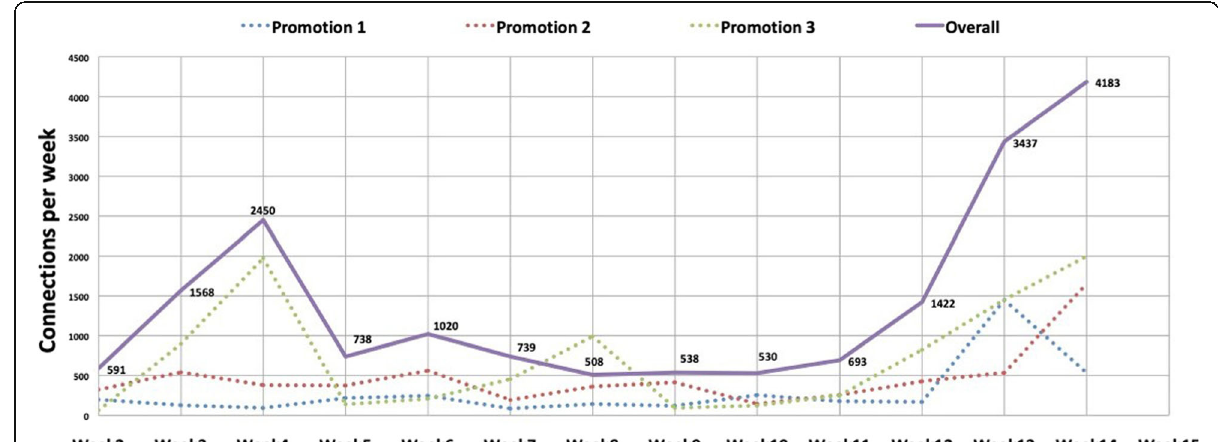
Fig. 4 Number of connections during each week of VBL availability. Two peaks are observed. After pretest (week 4) and before posttest (week